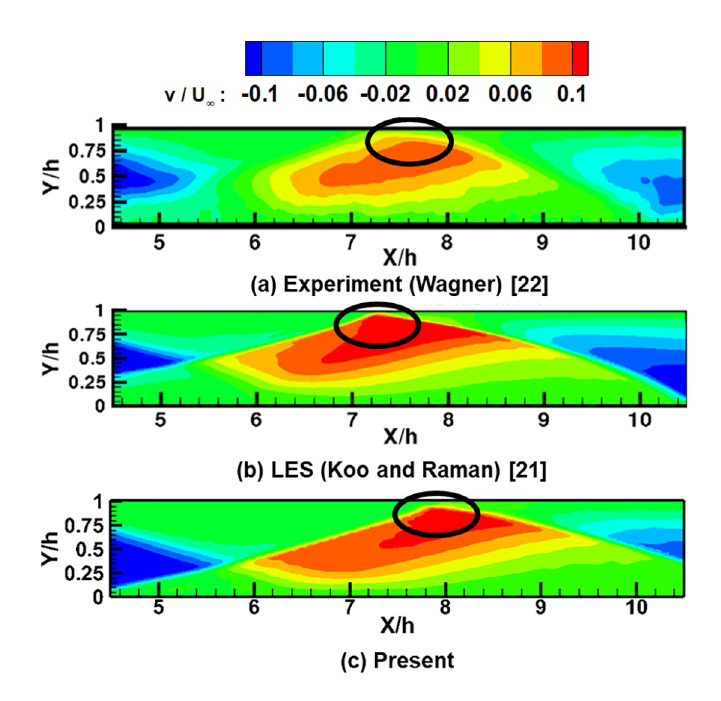
Fig 6. Normalized normal velocity contours of the inlet isolator for the start case. (a) Experiment (Wagner) [22]. (b) LES (Koo and Raman) [21]. (c) Present.